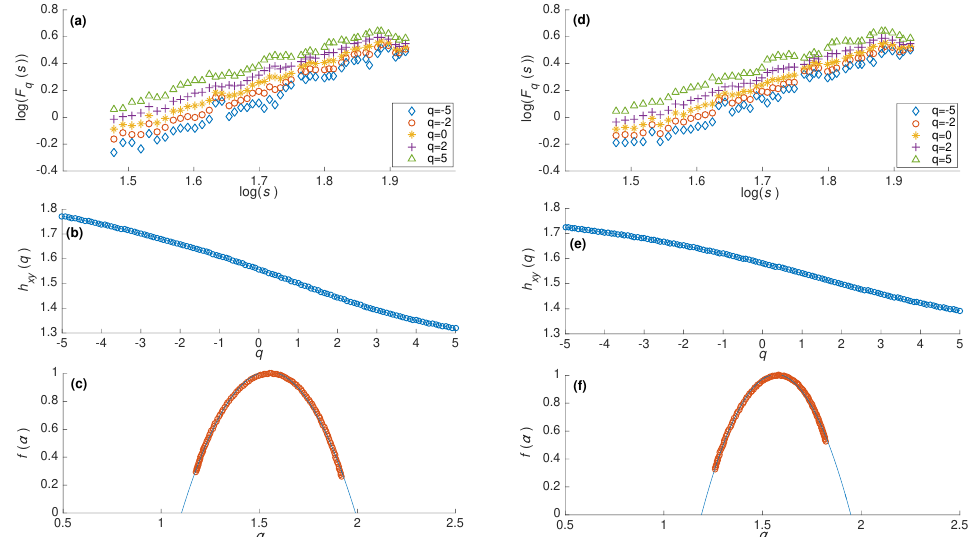
Figure 3. Multifractal Detrended Cross-Correlation Analysis (MF-DCCA) results between global CH 4 and global LT (left) and MT (right) temperature anomalies; ( a , d ) Plots of log( F q ( s )) against log ( s ); ( b , e ) Plot of h xy ( q ) against q ; and, ( c , f ) Multifractal spectrum f ( a ) against a